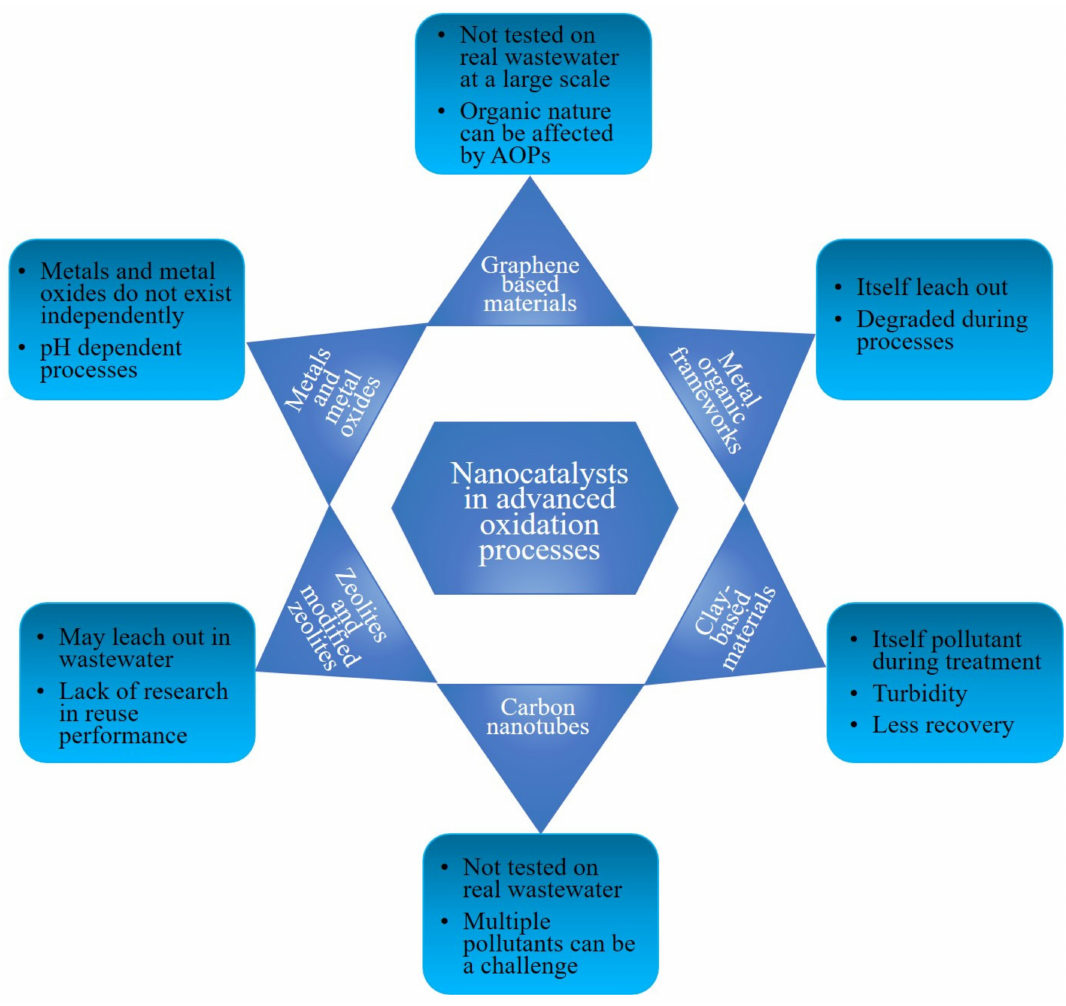
Figure 2. Nanocatalysts in AOPs and challenges for practical